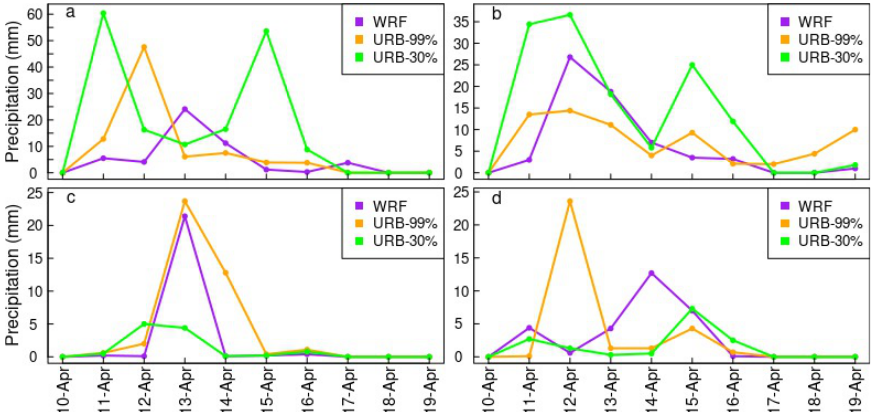
Figure 6. Daily precipitation for current LULC, future low-urbanization (URB-30%) and high-ur- banization (URB-99%) scenarios at ( a ) Dar, ( b ) Dar-Port, ( c ) Morogoro, and ( d ) Kibaha stations. Table 4. Daily precipitation difference (mm d −1 ) between future urbanization scenarios and current LULC at four stations.